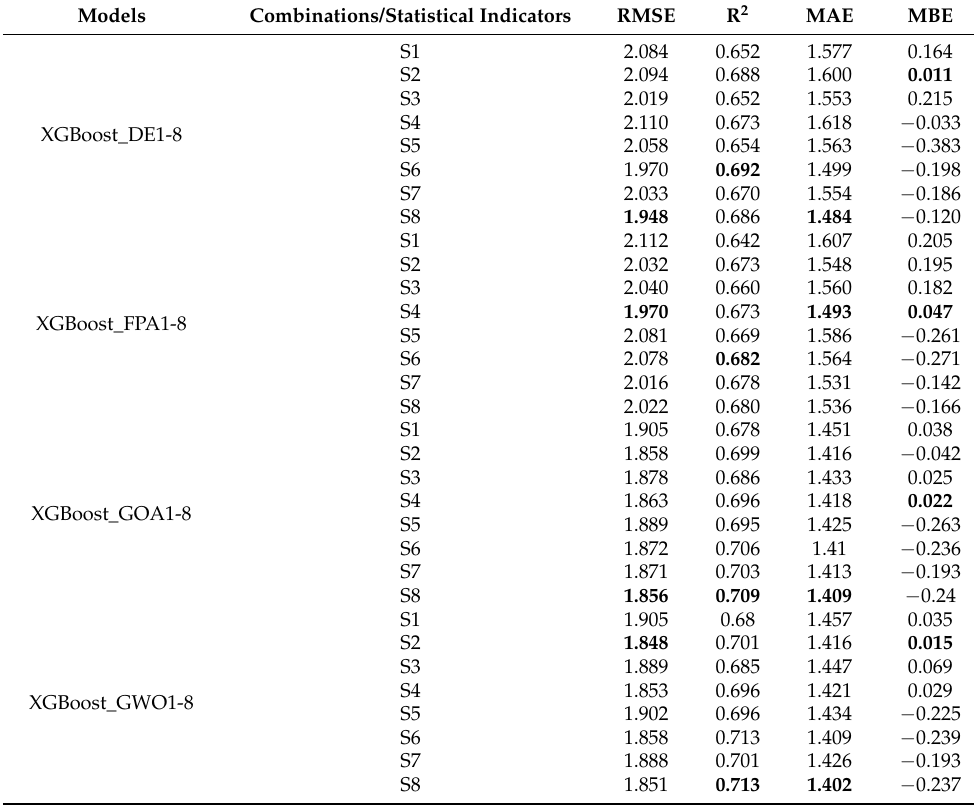
Table 6. Statistical results of the XGBoost_DE, XGBoost_FPA, XGBoost_GOA, and XGBoost_GWO models for R d prediction with eight combinations based on satellite data.